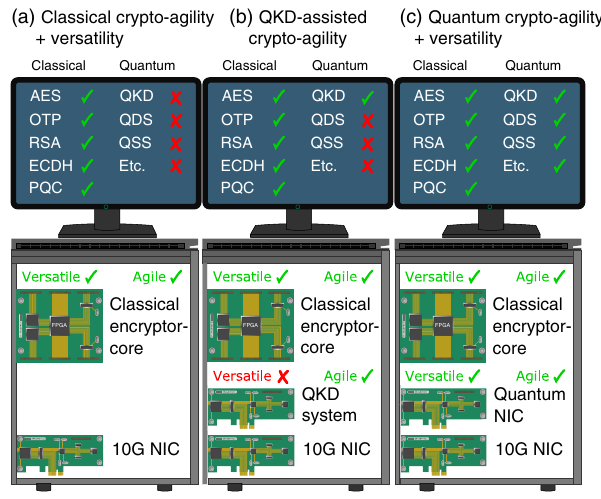
FIG. 1. Comparison between classical cryptoagility and the proposed agile and versatile quantum cryptography architecture. (a) Classical cryptoagility and versatility: Different classical cryptographic algorithms, such as Rivest-Shamir-Adleman (RSA), elliptic curve Diffie-Hellman (ECDHE), advanced en- cryption standard (AES), one-time pad (OTP), or postquantum cryptography (PQC) can be flexibly combined on the same hardware platform. A network interface card (NIC) is used to send and receive secure communication. (b) QKD-assisted cryptoagility: Classical cryptographic algorithms make use of a pool of secret keys generated by a QKD cryptocore. The quantum functionality is tied to the hardware implementation and cannot be upgraded easily, e.g., to perform QDS or QSS. (c) Quantum cryptoagility: Classical cryptographic algorithms and different quantum protocols can be swapped out and combined as necessary, requiring no changes to the underlying hardware architecture. 10G NIC — 10 Gb/s Ethernet network interface